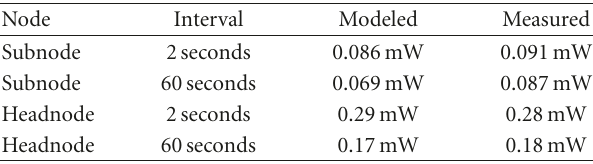
Table 6: Modeled power consumption against measured power derived from radio duty